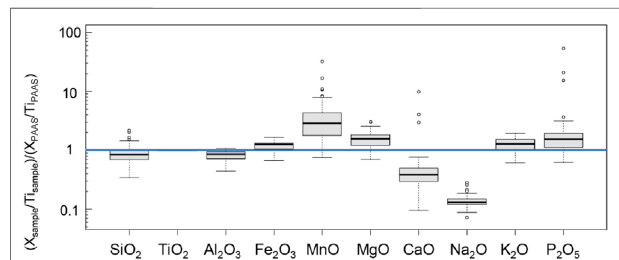
FIGURE 4 | PAAS (Post-Archean Australian Shale)-normalized elemental abundance of the intercalated mudstone of the bedded chert from Section R and Section Q. Boxes indicate the 25th and 75th percentiles. The horizontal line in each box marks the median value. Whiskers represent the 1.5 times the interquartile range of the data. Open circles represent data outliers. Note that the vertical axis is a logarithmic scale. PAAS data are from Taylor and McLennan